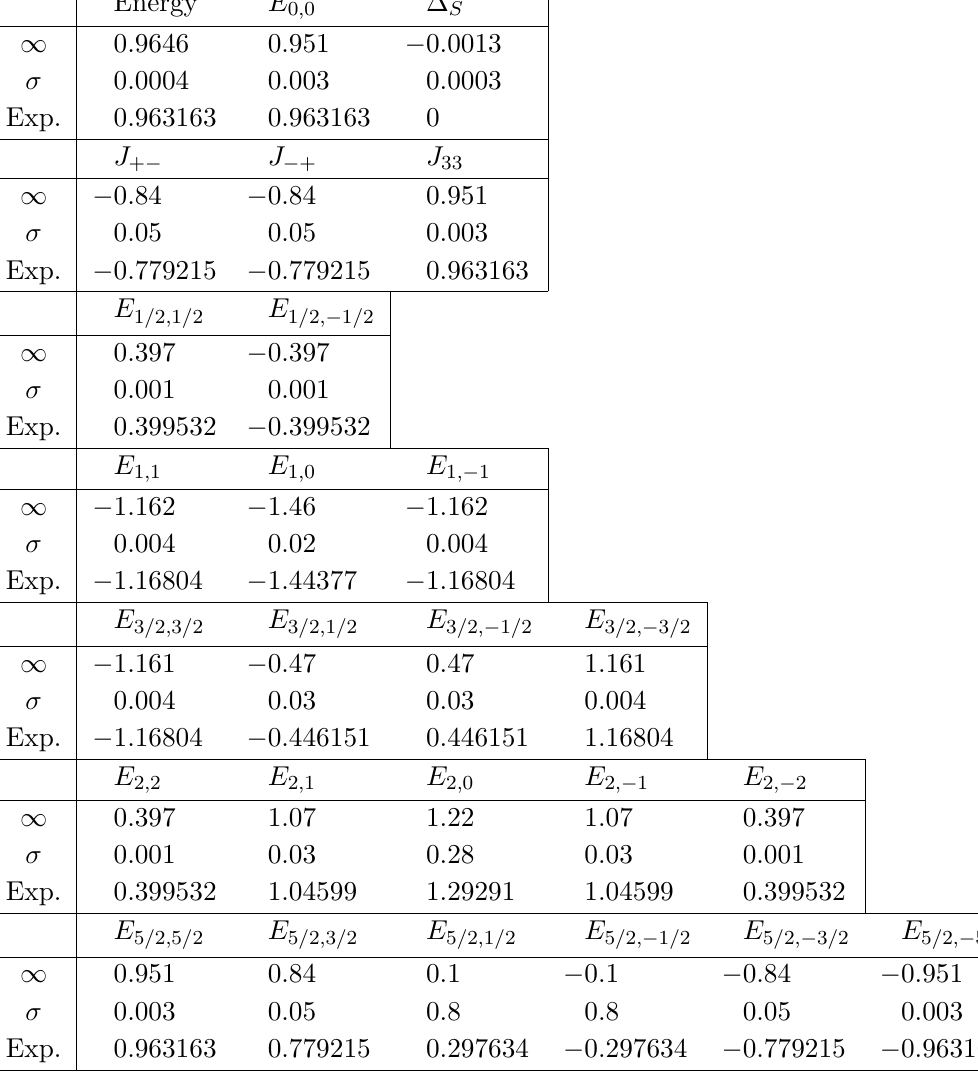
Extrapolations of invariants of the final two 0-brane solution are given in table